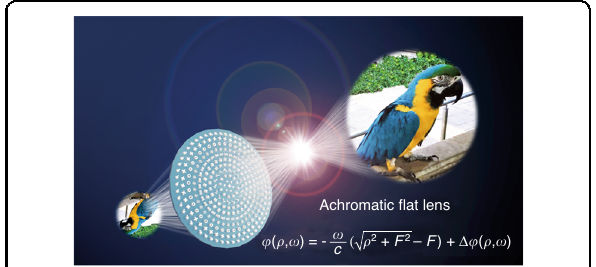
Fig. 1 Operation principle of achromatic fl at lenses. Schematic of large-area achromatic fl at